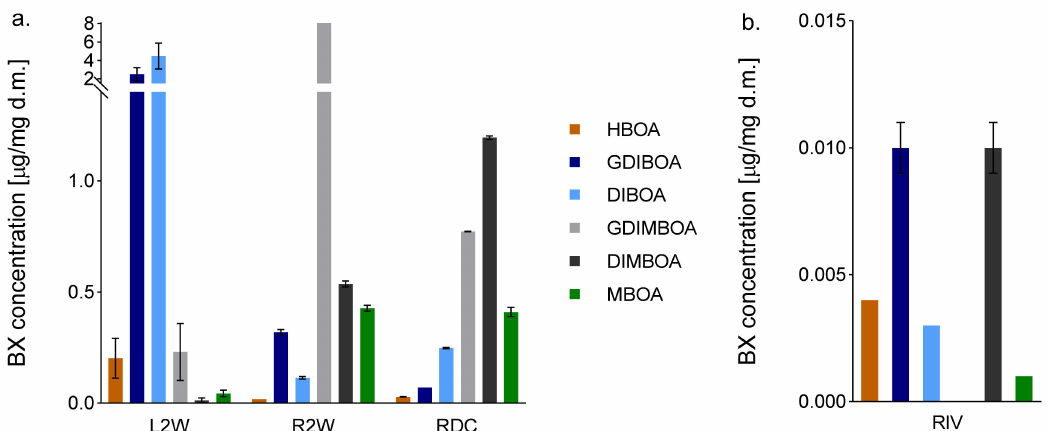
Figure 2. Concentrations of benzoxazinoids (BXs) in roots developed from ( a ) seeds deprived of coleoptile 2 days after sowing (RDC), roots (R2W) and leaves (L2W) of 2-week-old seedlings; and ( b ) roots developed in vitro (RIV) of rye inbred line L318. Data mean ± SD of three biological